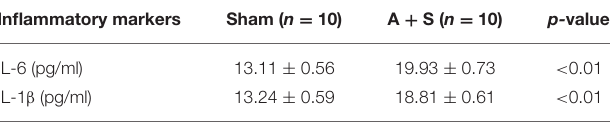
Data are shown as mean ± SEM (n = 10). p < 0.05 compared with the sham group. A + S: anesthesia/surgery.